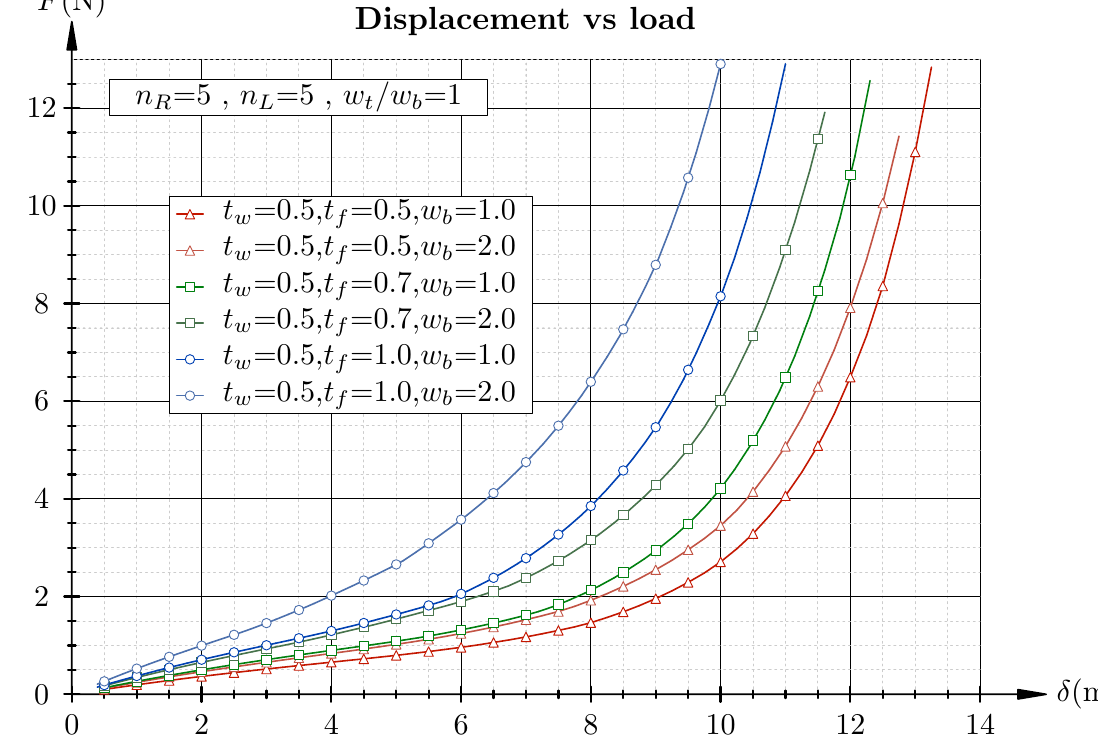
Figure 8. Variation of the radial force for selected values of fiber bottom width w b and fiber thickness t f